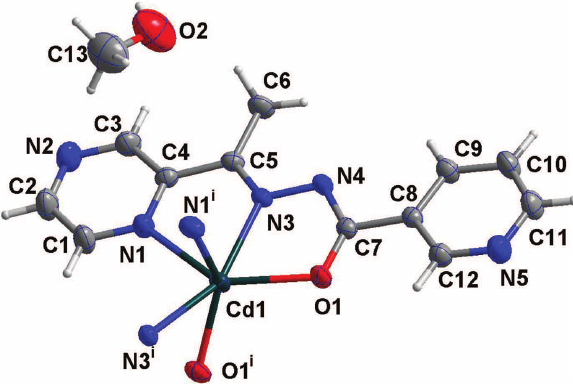
Table 2: Fractional atomic coordinates and isotropic or equivalent isotropic displacement parameters (Å 2